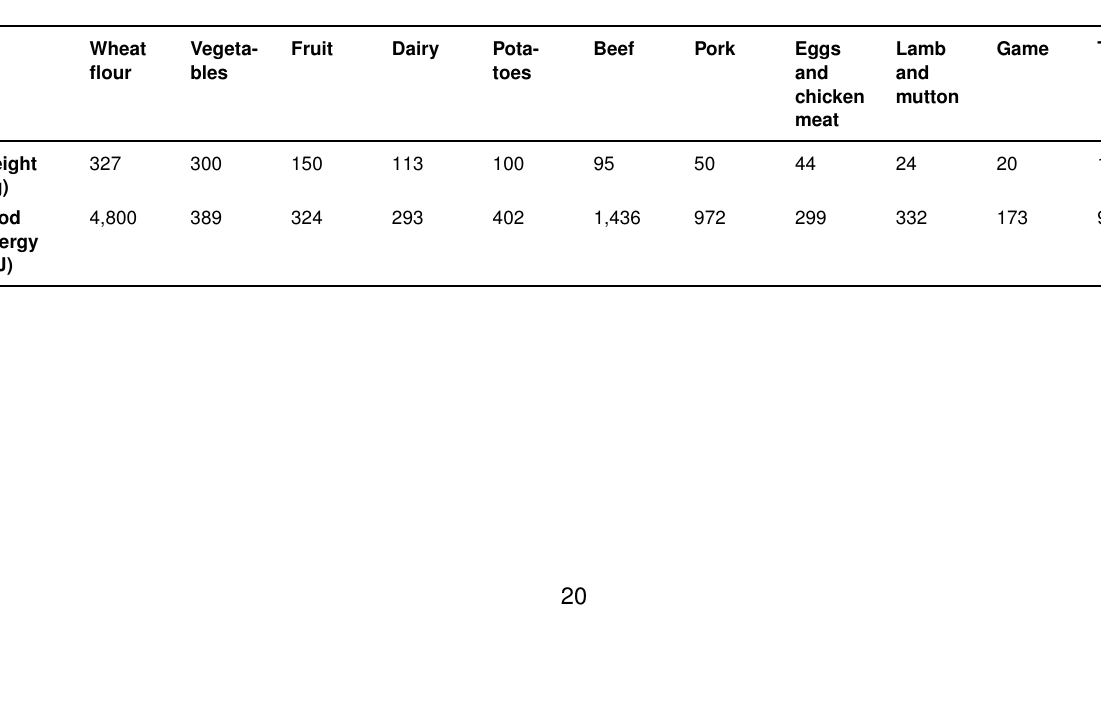
Table 9. Balanced diet scenario, annual outputs of